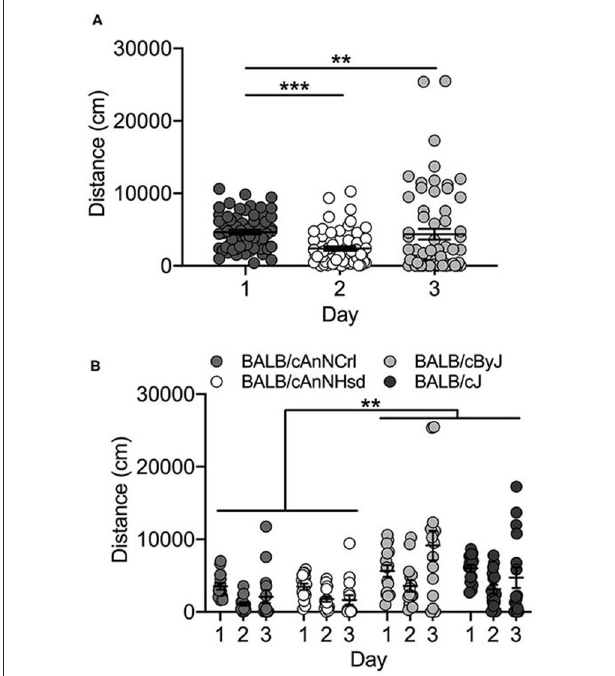
FIGURE 2 | BALB/c substrains are not activated in response to cocaine. (A) Regardless of substrain, locomotor activity was significantly higher on Day 1 in response to saline in comparison to Day 2 activity (saline) and Day 3 cocaine-induced locomotor activity. (B) BALB/c substrains were significantly more active than BALB/cAn substrains across all three days. Each data point represents an individual mouse, error bars are standard error of the mean. ** p < 0.01; *** p <